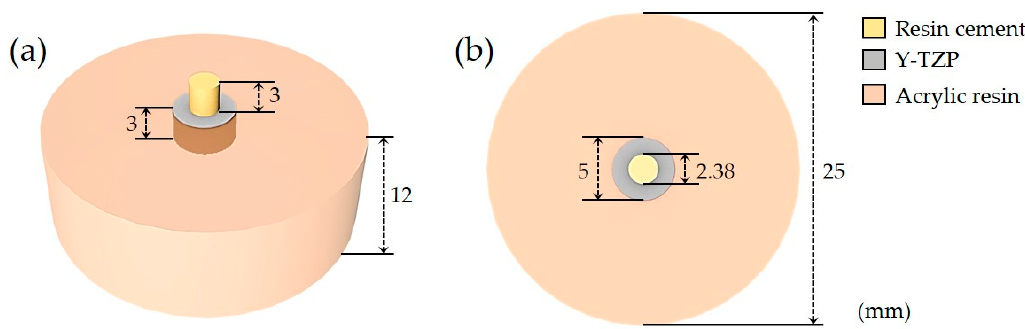
Figure 4. Three-dimensional schematic image of the Y-TZP specimen for the Shear Bond Strength (SBS) test. ( a ) Top-front view and ( b ) top view of the specimen.